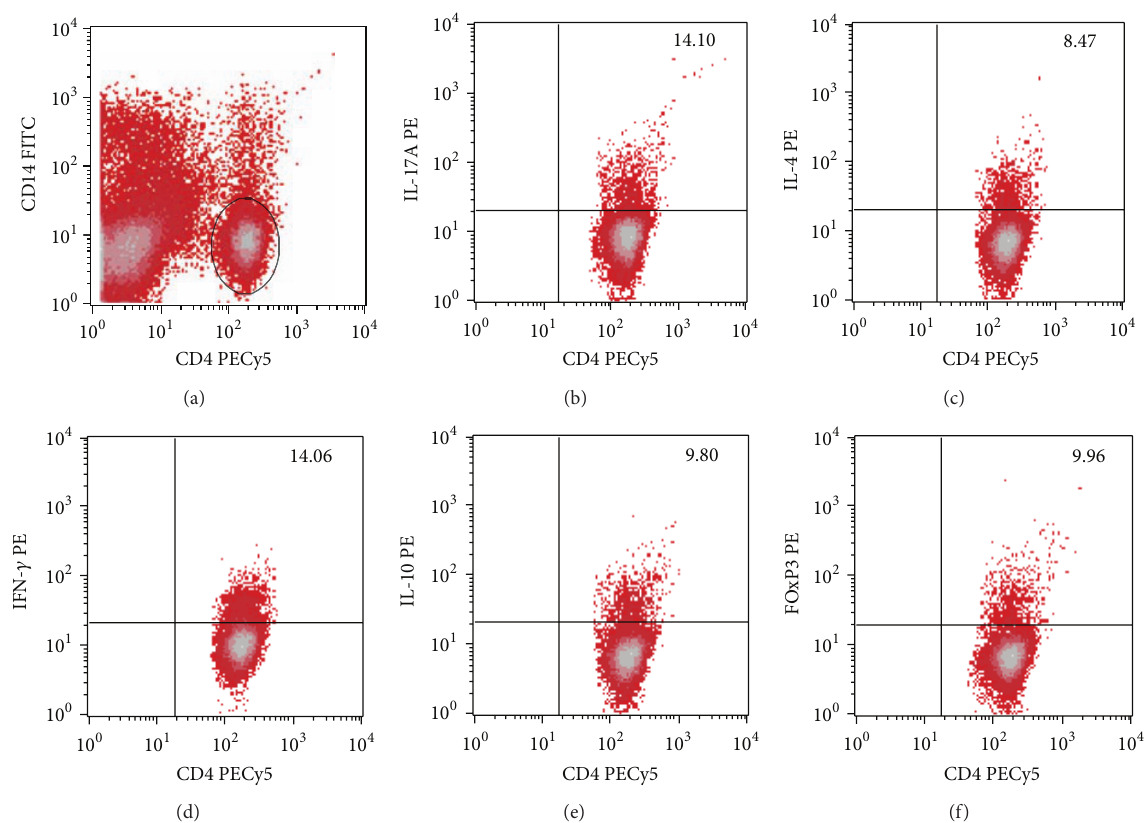
Figure 1: Density plots of cytokine-expressing CD4 + T peripheral cells in IBD (UC and CD) patients. (a) CD14 − /CD4 + T cells were determined. (b) From the latter CD14 − /CD4 + /IL-17A + cells were defined. (c) From the gate 𝐴 CD14 − /CD4 + /IL-4 + cells were determined. (d) From the gate 𝐴 CD14 − /CD4 + /IFN- 𝛾 + cells were defined. (e) From the gate 𝐴 CD14 − /CD4 + /IL-10 + cells were determined. (f) CD4 + /CD 25 hi /Foxp3 + cells were defined. A total of 50,000–100,000 events were recorded for each sample before any gate setting and analysed with the CellQuest Pro software (BD